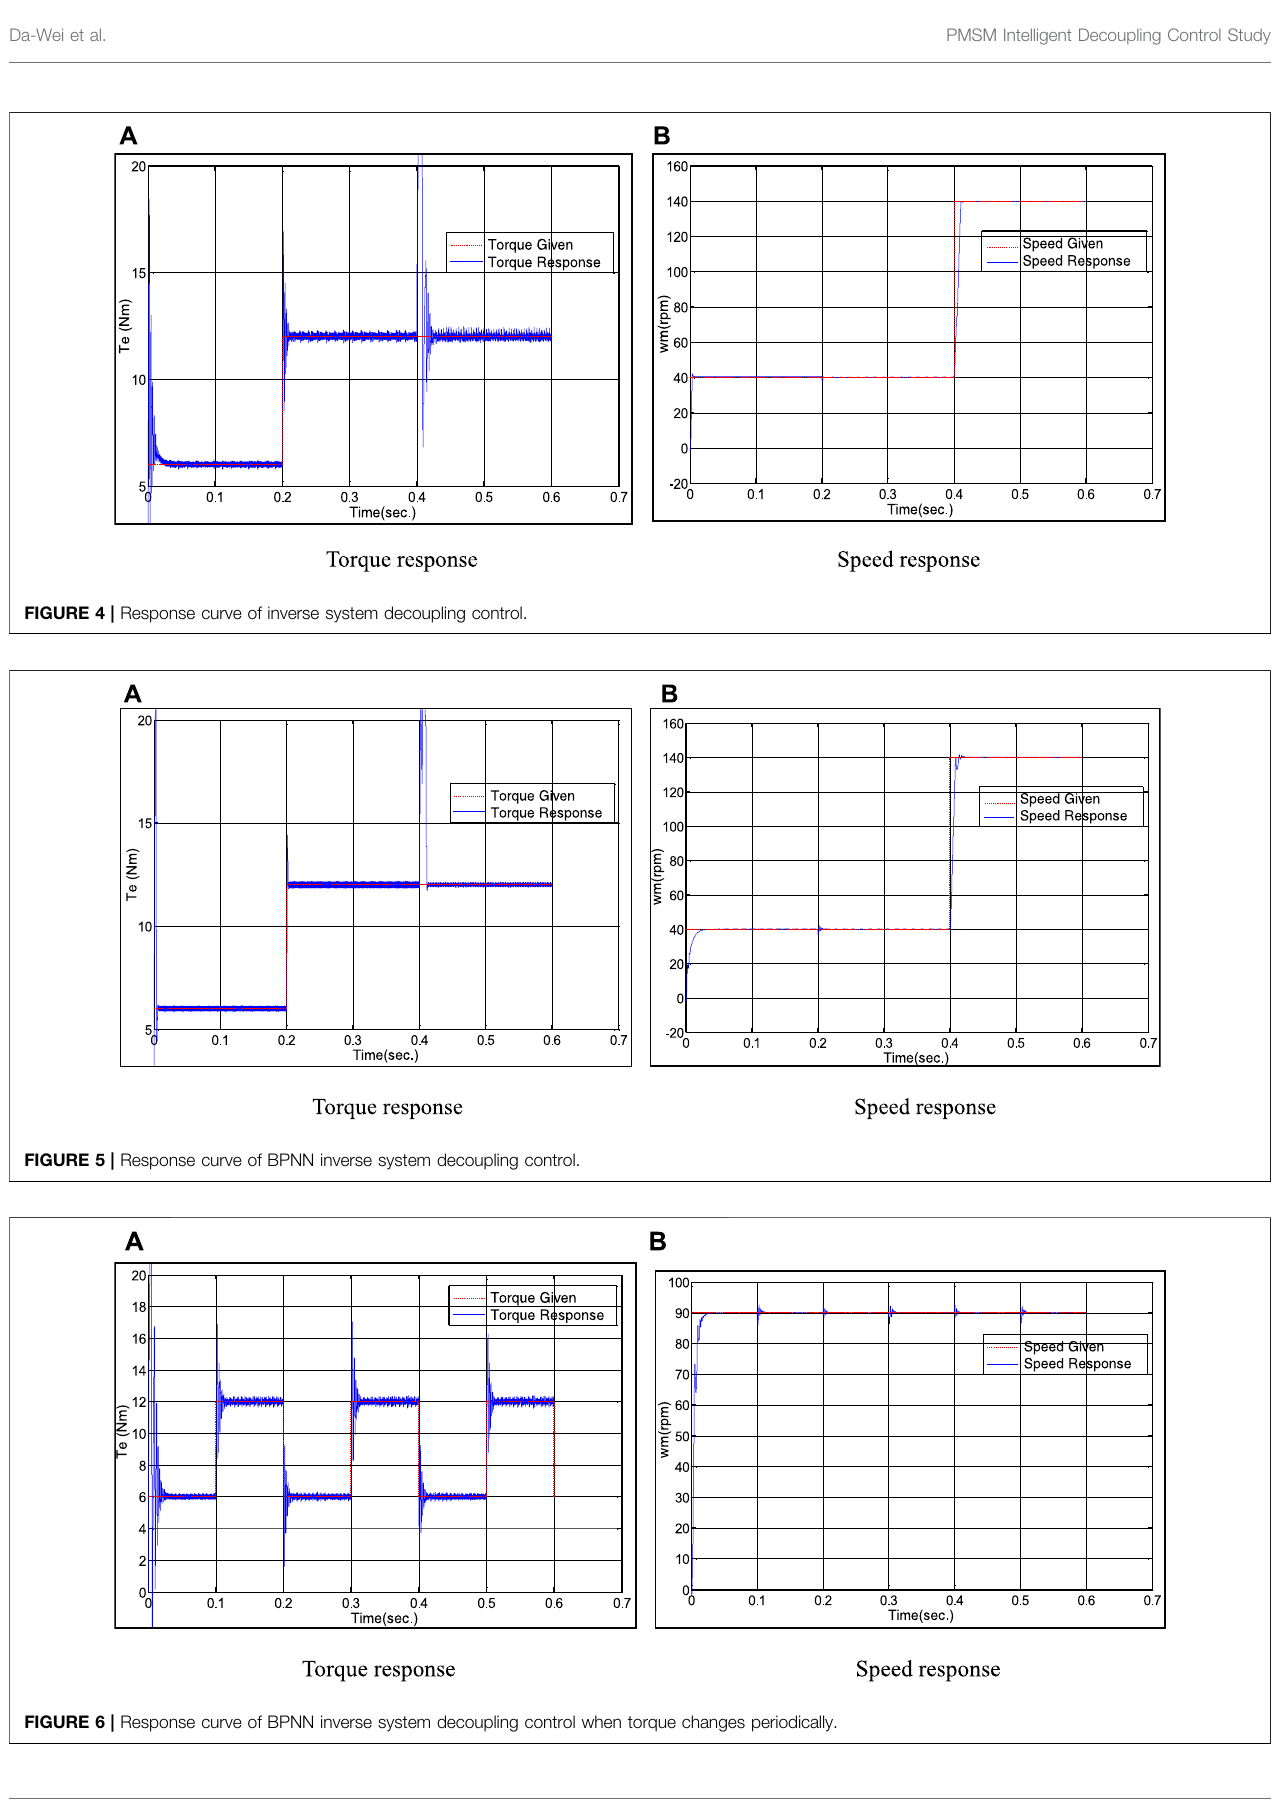
Frontiers in Energy Research |